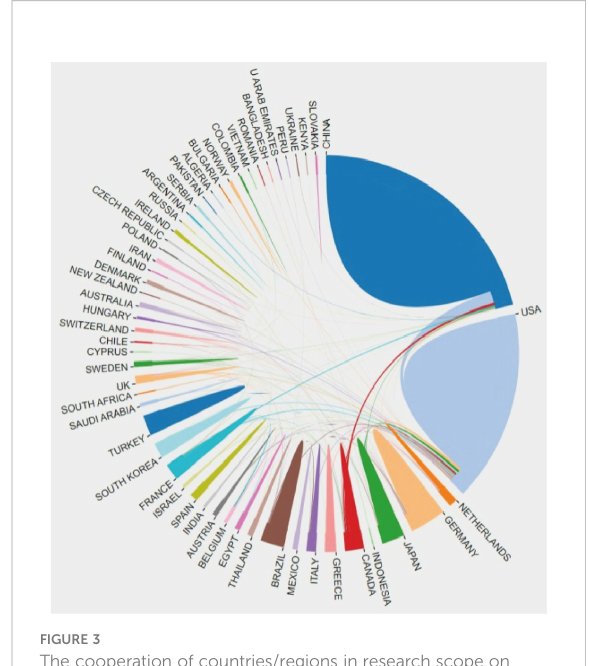
FIGURE 3 The cooperation of countries/regions in research scope on sepsis and programmed cell death from 2002 to 2022.